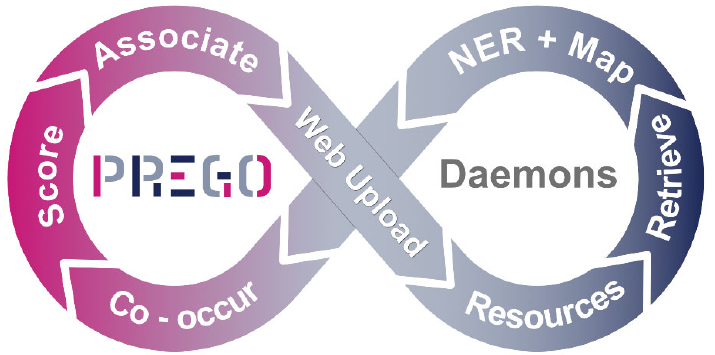
Figure A1. Software daemons perform all steps of the PREGO methodology in a continuous manner similar to the Continuous Development and Continuous Integration method.